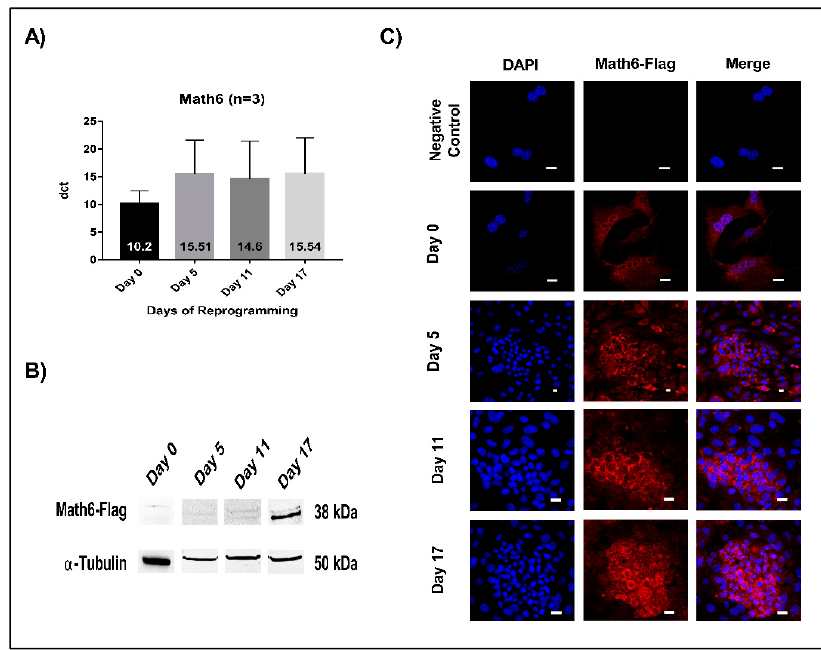
Figure 1. Math6 expression during somatic cell reprogramming . ( A ) mRNA expression of Math6 on Day 0 (Untransduced fibroblasts), 5, 11 and 17 of reprogramming generated by Day 0 (Untransduced fibroblasts), 5, 11 and 17 of reprogramming generated by RT-PCR. The